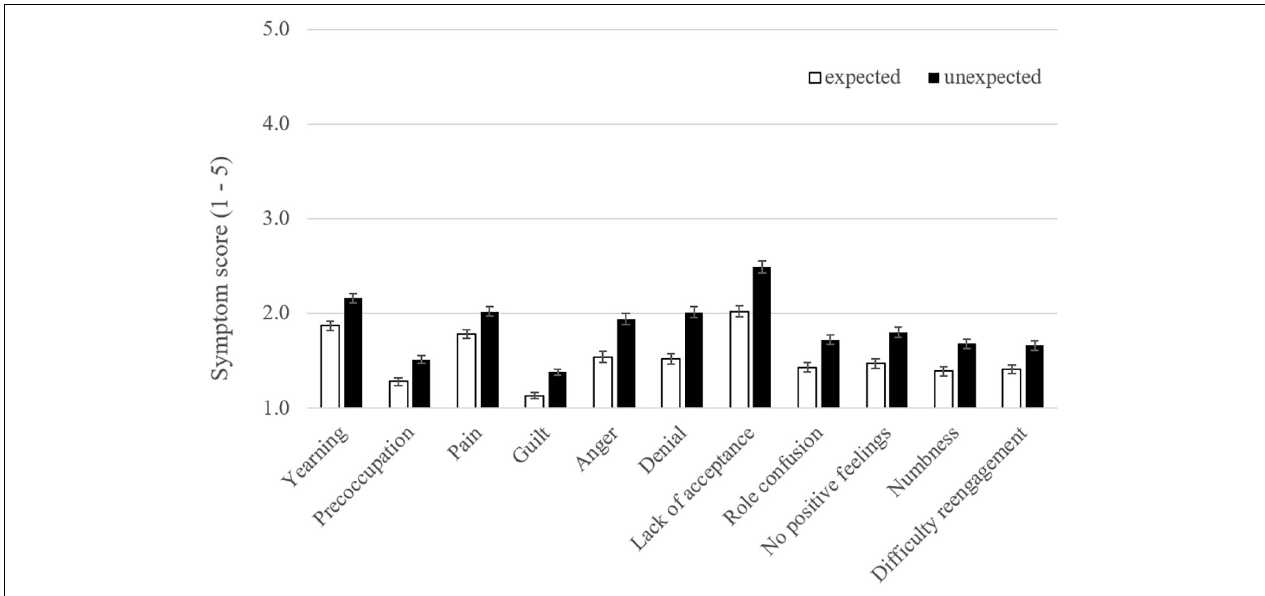
FIGURE 2 | Mean scores of grief symptoms as a function of the expectedness of the loss.